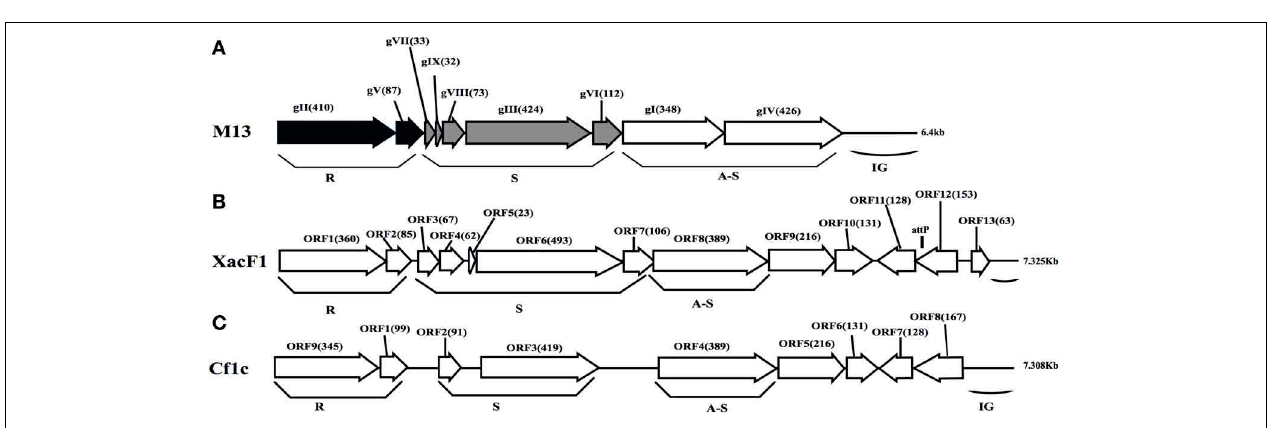
FIGURE 2 | Genomic organization of bacteriophage XacF1. Linear genomic maps of E. coli phage M13 (A) , XacF1 (B) , and Cf1c (C) are compared. Arrows oriented in the direction of transcription represent ORFs or genes. The functional modules for replication (R), structure (S), and